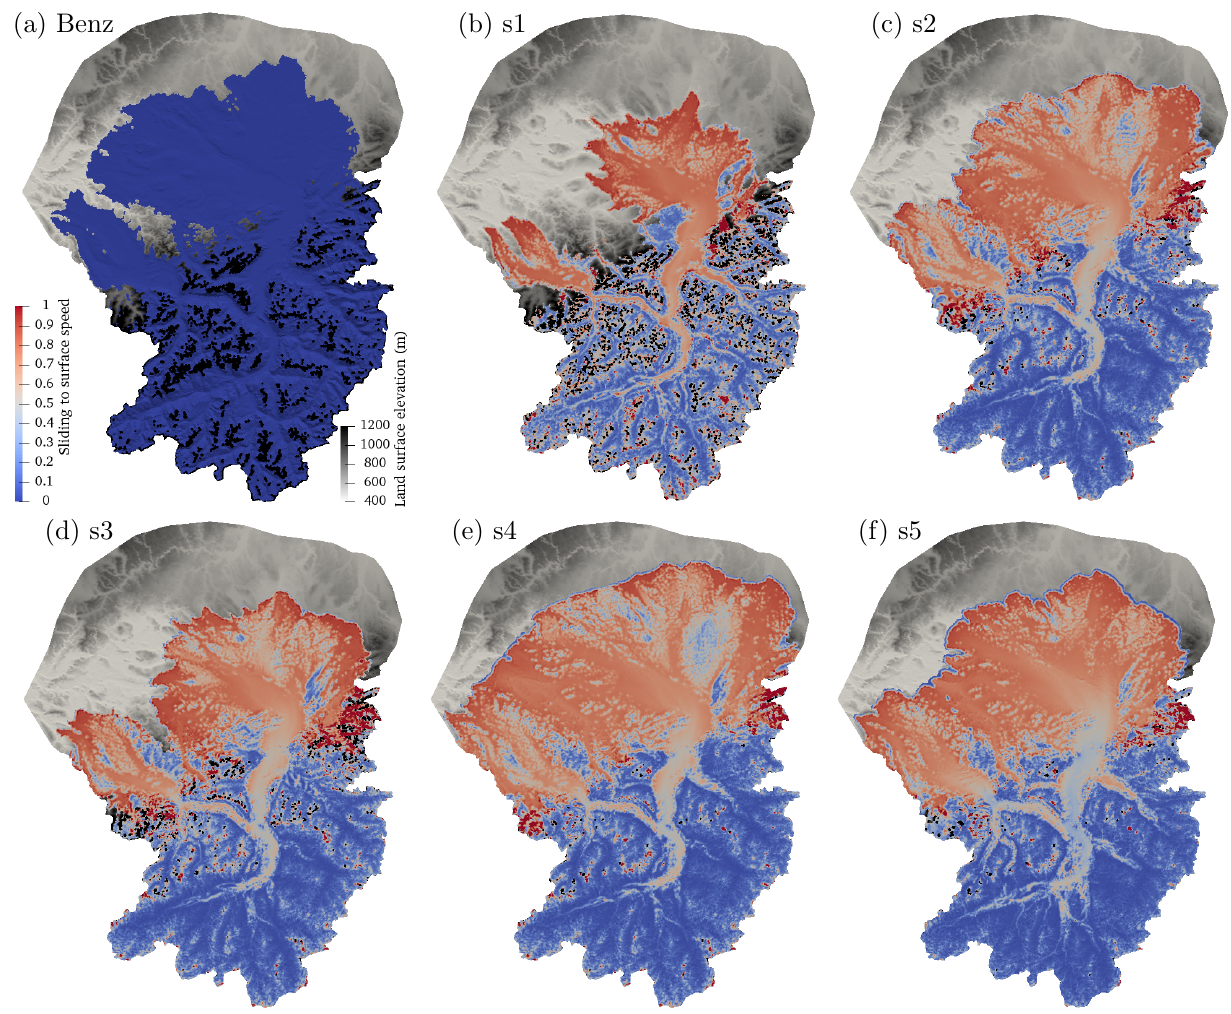
Figure 11. Ratio of sliding to surface speed for (a) Benz-Meier (2003) (no sliding assumed) and (b–f) simulations